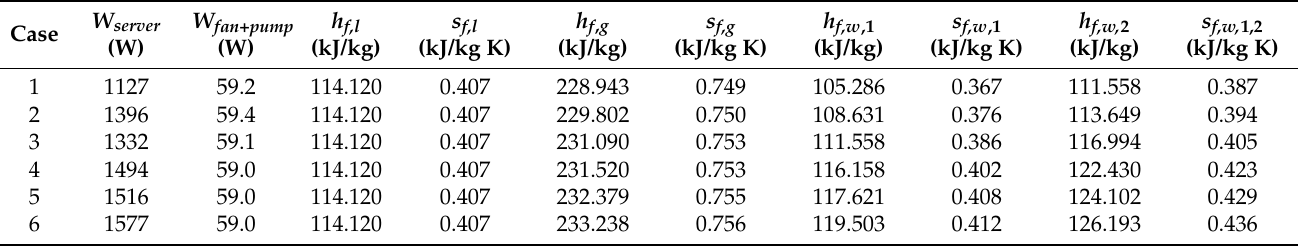
Table 6. Operation values under six